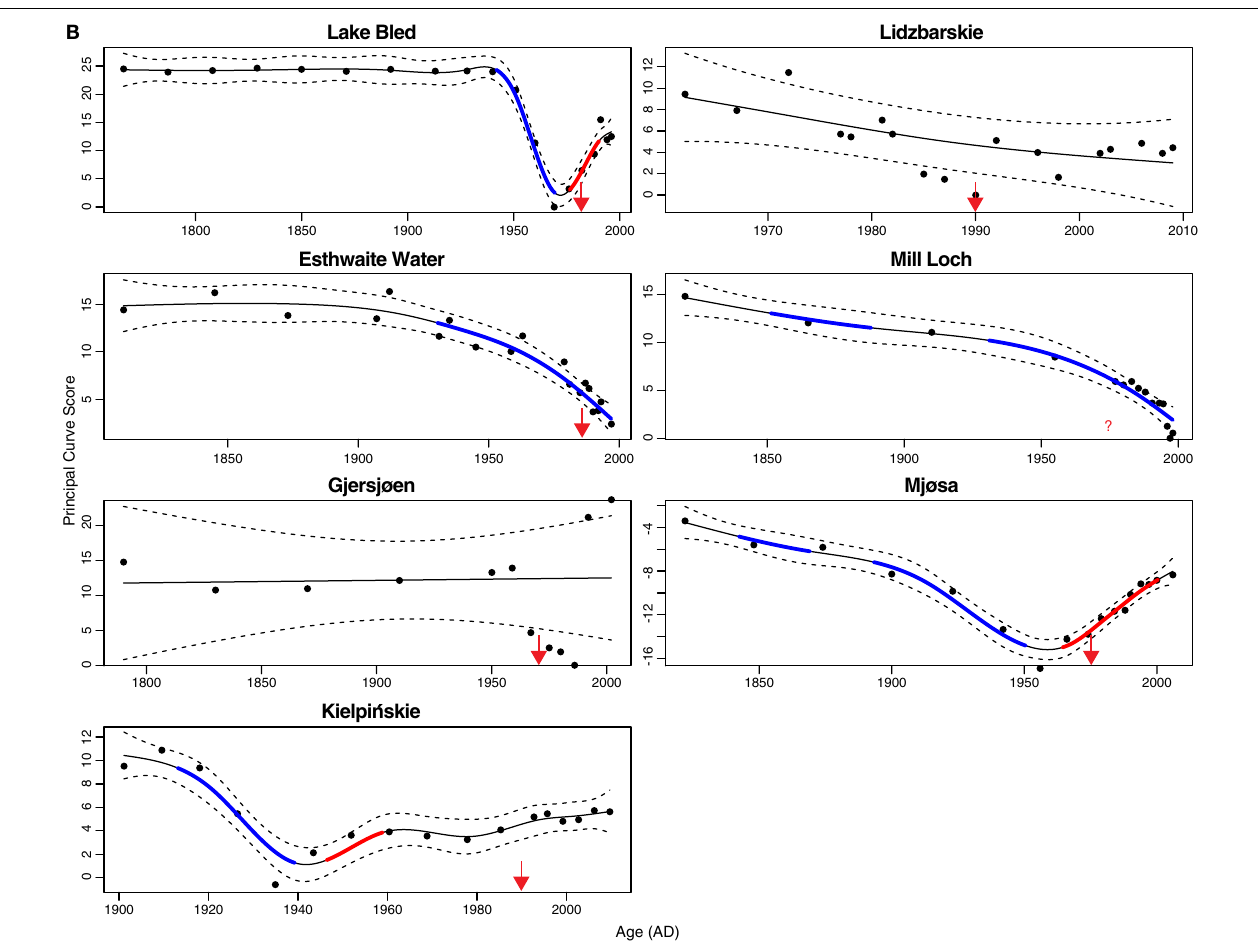
FIGURE 4 | Principal curve fits with derivatives for (A) shallow lakes and (B) deep lakes. Blue and red lines indicate significant decrease and significant increase in PrC scores, respectively. Dashed lines are 95% confidence intervals. Timing of first nutrient reduction is shown by the arrow.